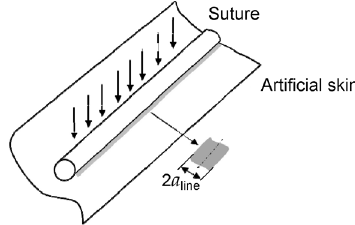
Fig. 3 Schematic drawing of Hertzian contact between a surgical suture and an artificial